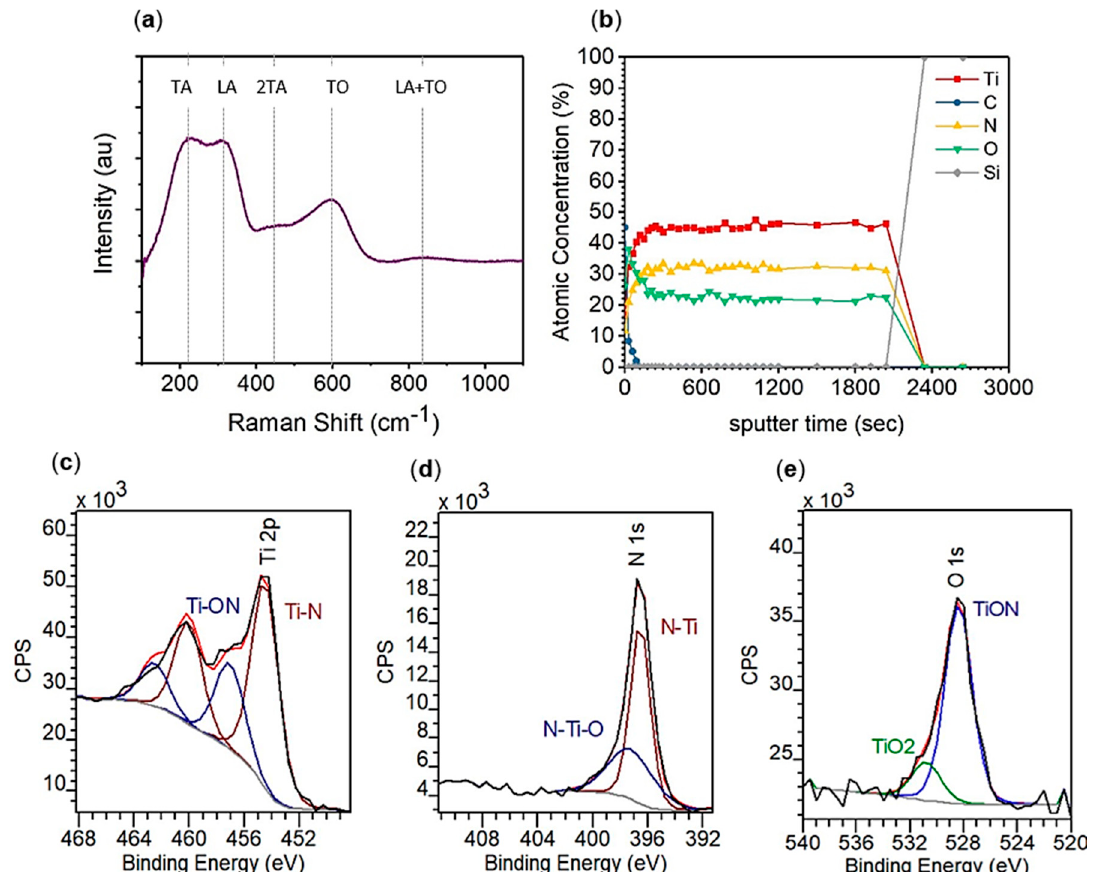
Figure 1. Structural characterization of 400 ALD cycles TiN on MgO using ( a ) Raman spectroscopy and XPS ( b ) depth profile, ( c ) titanium 2p region, ( d ) nitrogen 1s region, and ( e ) oxygen 1s region.